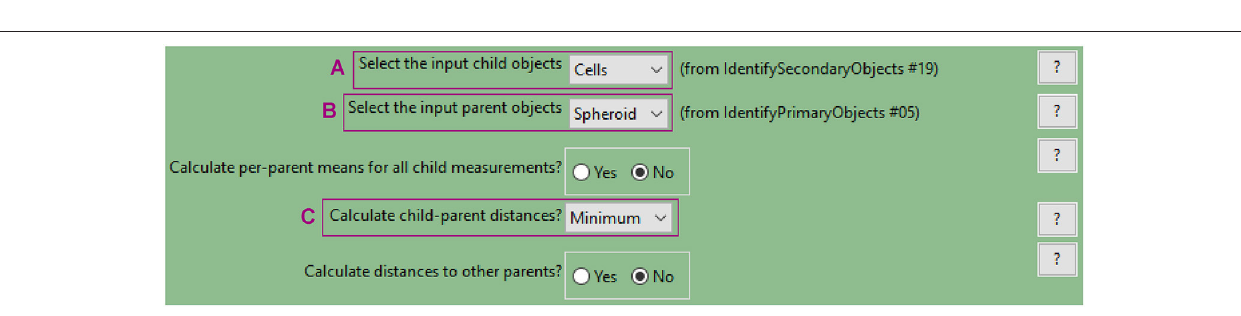
FIGURE 10 | CellProfiler “RelateObject” module. Parameters used to measure cell-to-spheroid-surface distance for analysis shown in Figure 3